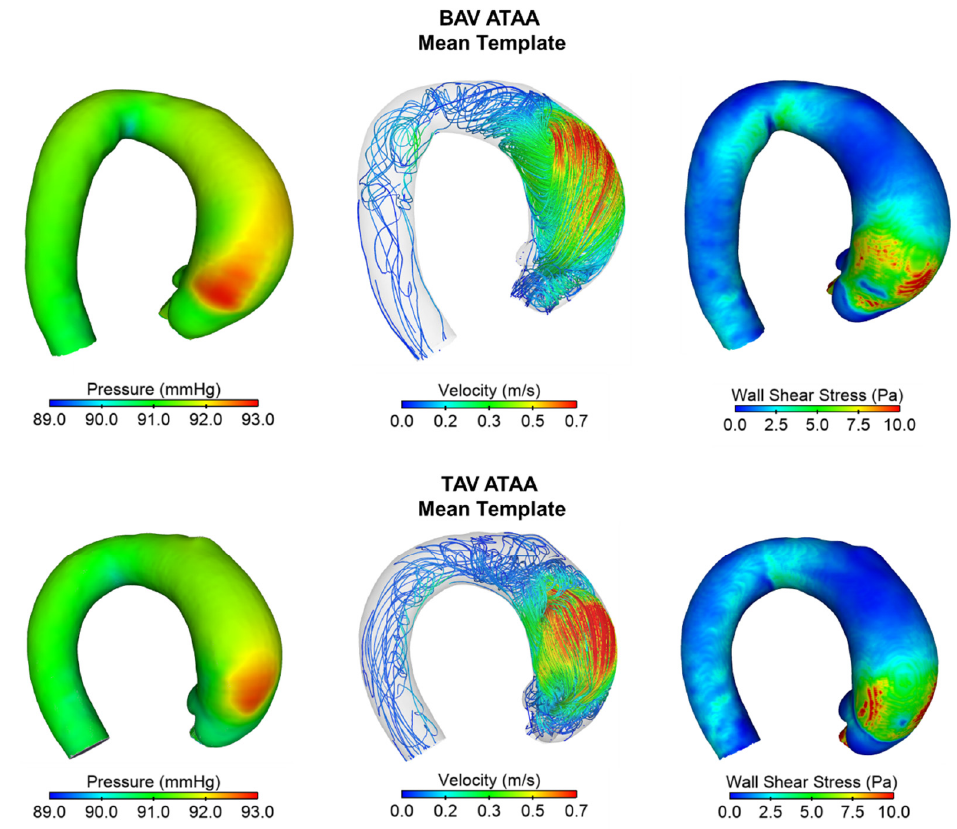
Figure 5. Distribution of time-averaged pressure ( left ), flow velocity ( middle ), and WSS ( right ) in both TAV and BAV ATAA mean templates.